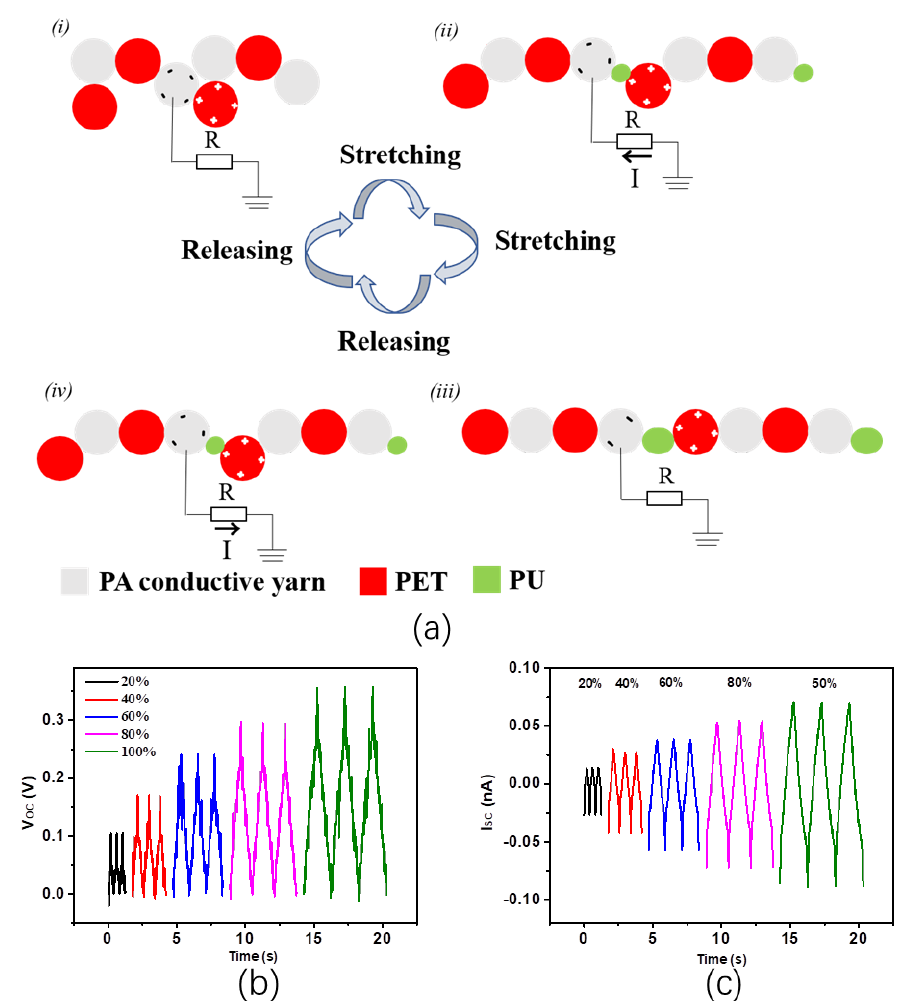
Figure 5. ( a ) The working mechanism of SWF-TENG with twill weave, ( i ) In the original state without stretch; ( ii ) The SWF-TENG is gradually stretched; ( iii ) The SWF-TENG is stretched to the largest deformation; ( iv ) The SWF-TENG is recovering to the original state; ( b , c ) Electrical output performances of SWF-TENG with twill structure.